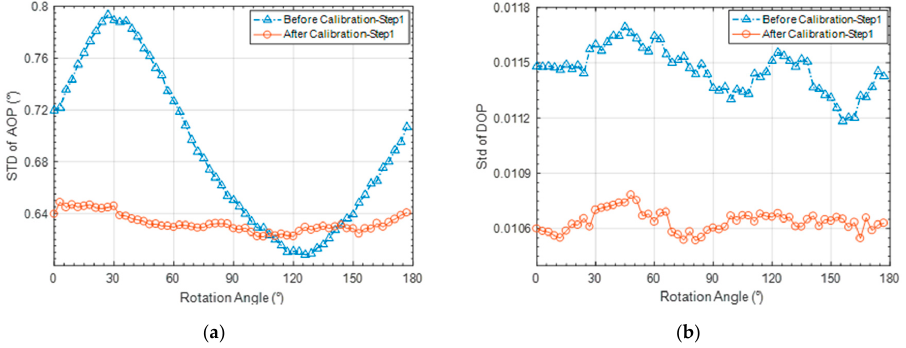
Figure 7. ( a ) AOP and ( b ) DOP SD comparison before and after calibration experiment of CMOS camera photosensitivity model. camera photosensitivity